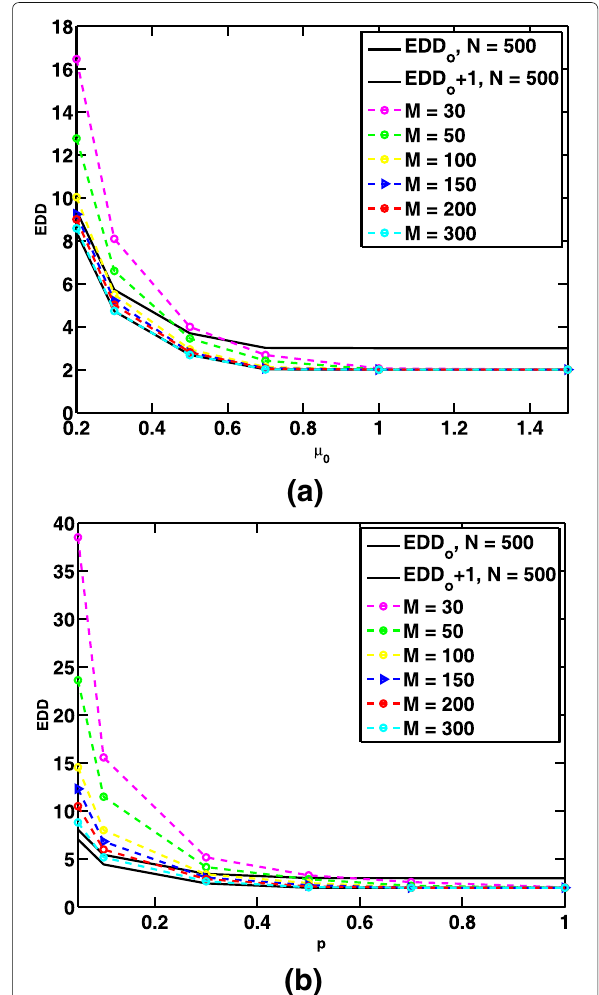
Fig.6 A being a fixed expander graph. The standard deviation of each point is less than half of its value. a EDD versus μ 0 , when all [ μ ] i = μ 0 ; b EDD versus p when we randomly select 100 p % entries [ μ ] i to be 1 and set the other entries to be 0; the smallest value of p is